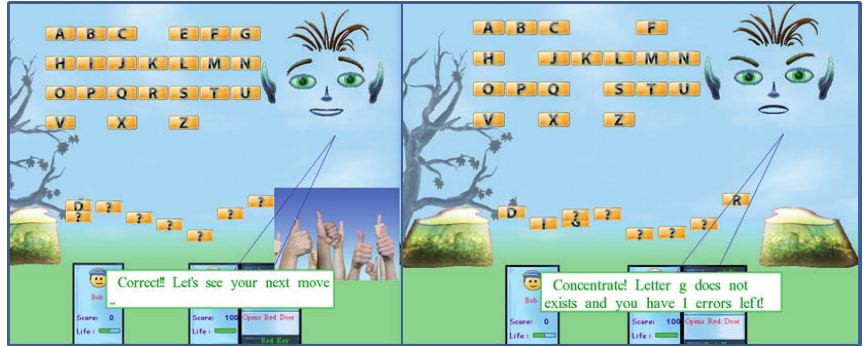
Figure 13: Screenshots from the Hangman